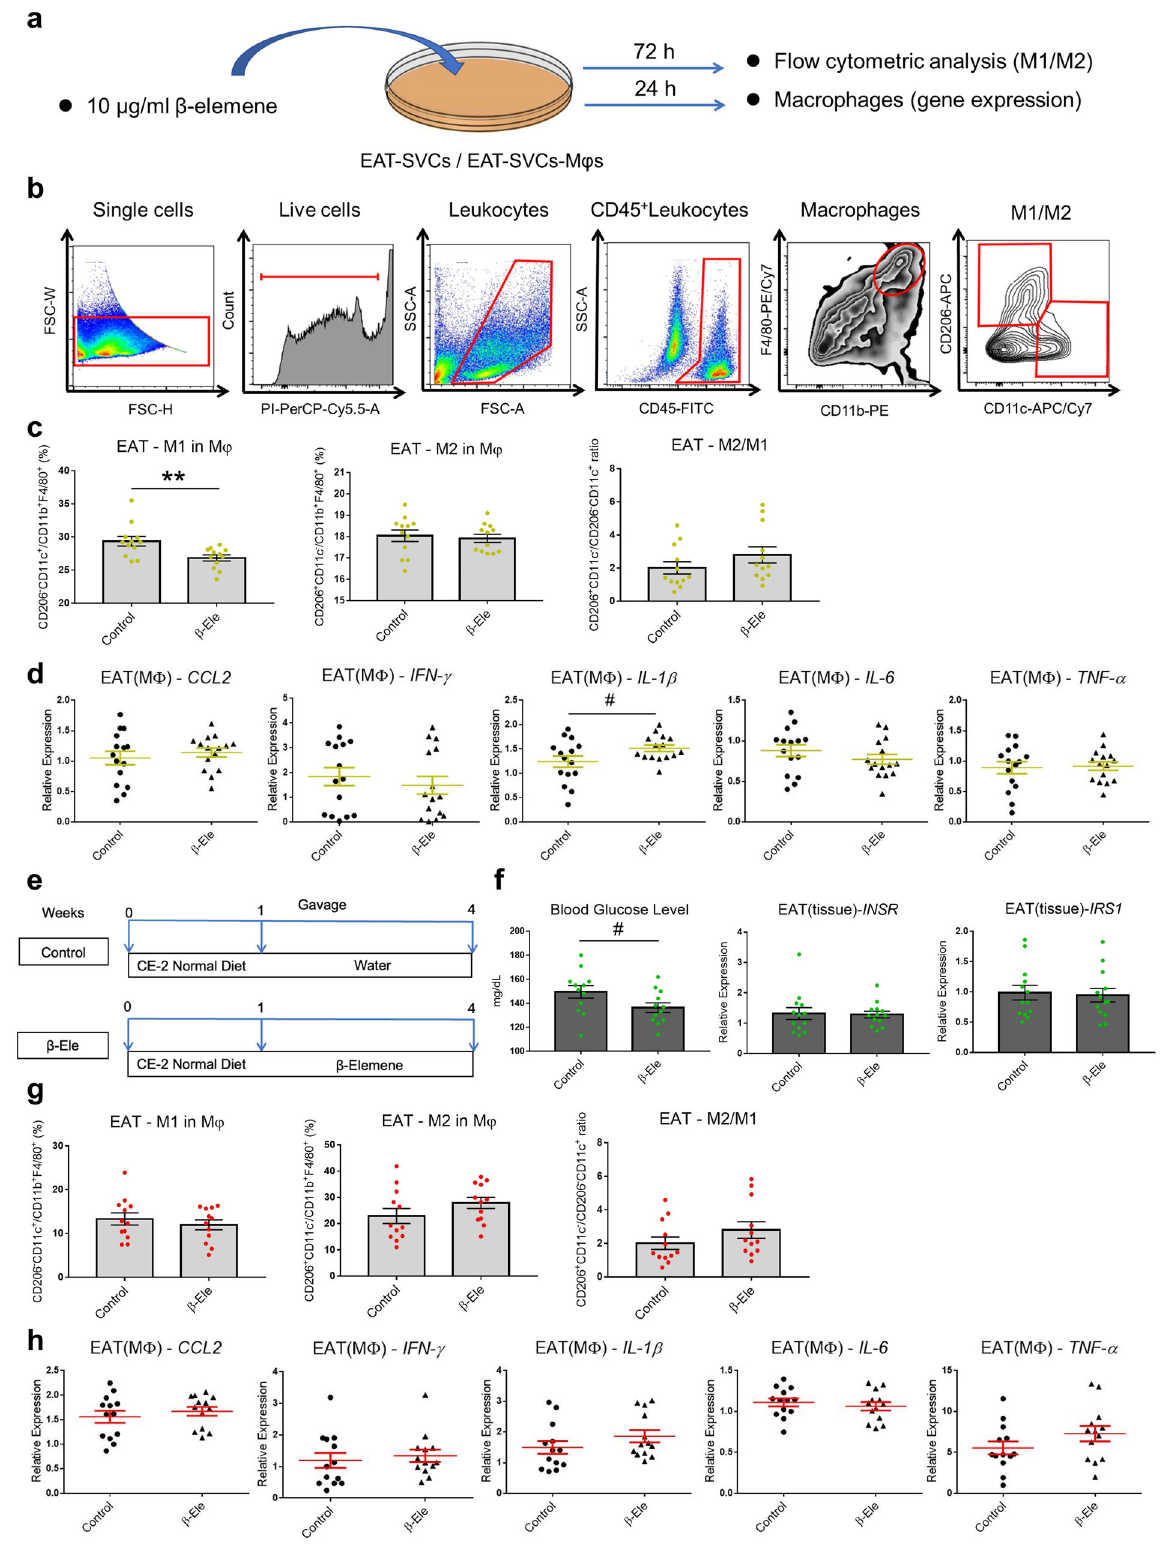
elemene ’ s effects on regulating the polarization of ATMs of murine white adipose tissue, the gene expression of pro-in fl ammatory cytokines was examined in vitro. Except for IL-1 β , other pro- in fl ammatory cytokines derived from EAT-ATMs including CCL2, IFN- γ , IL-6 , and TNF- α were not in fl uenced by β -elemene treat- ment (Fig. 3d). For the in vivo experiments, the effects